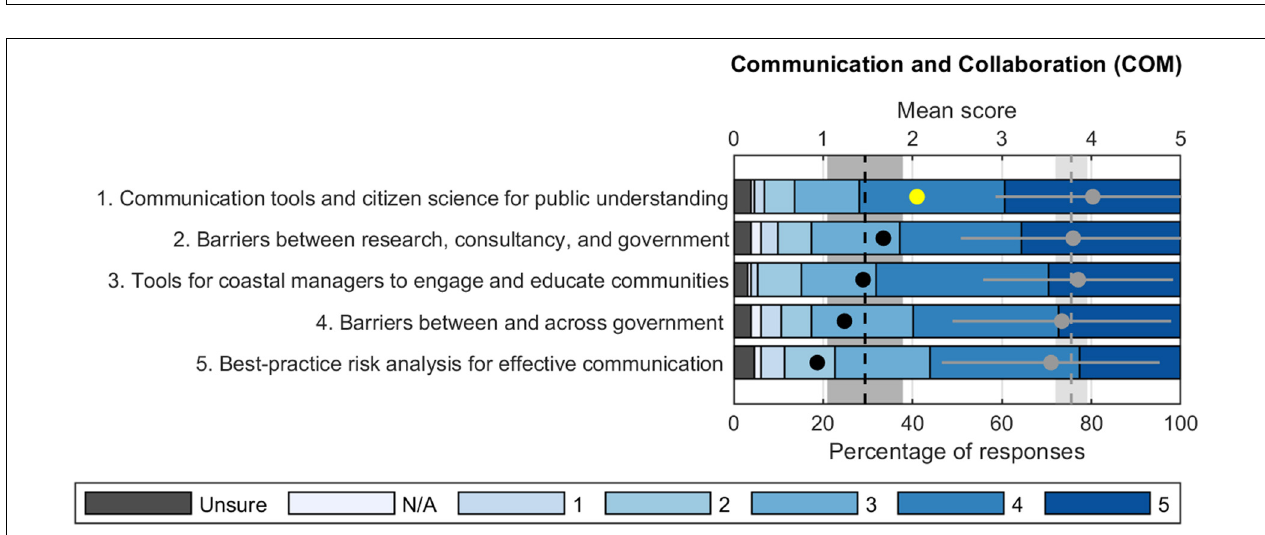
FIGURE 10 | Stacked bar plot showing the distribution of Stage 3 respondent scores for priorities in the Communication and Collaboration (COM) category. See Figure 5 for full caption.